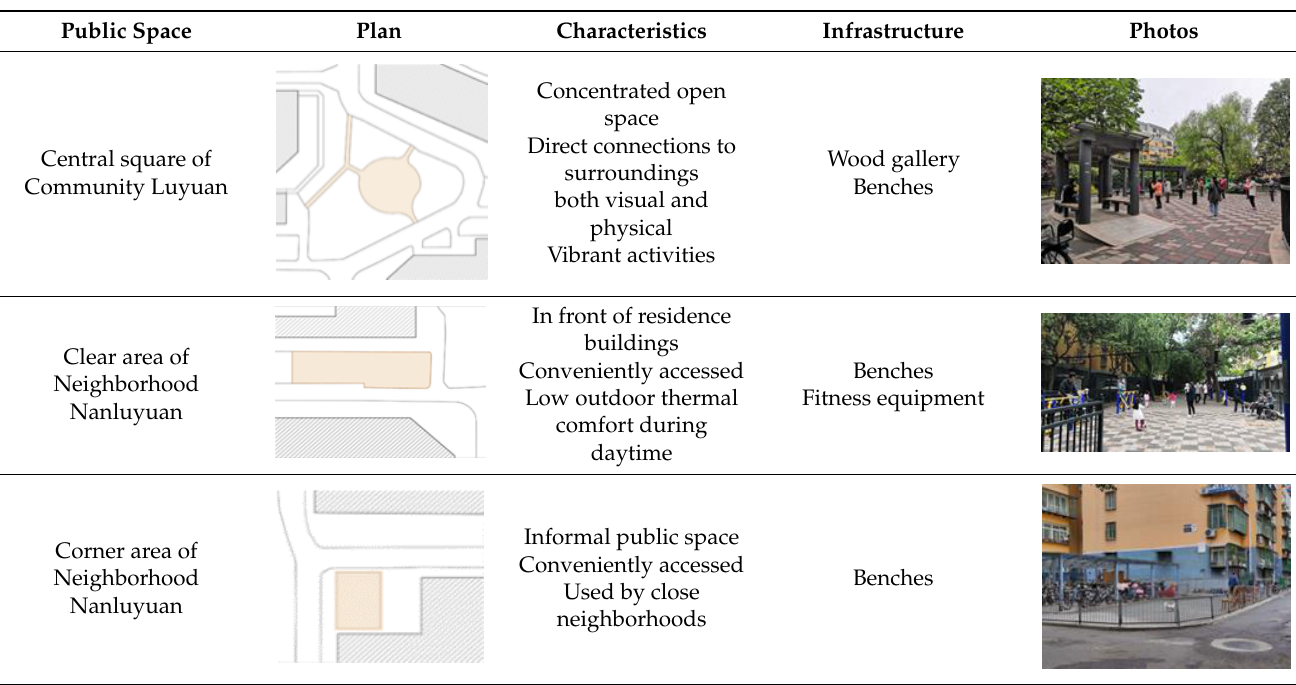
Table 2. Public space observation and mapping of Community Luyuan.